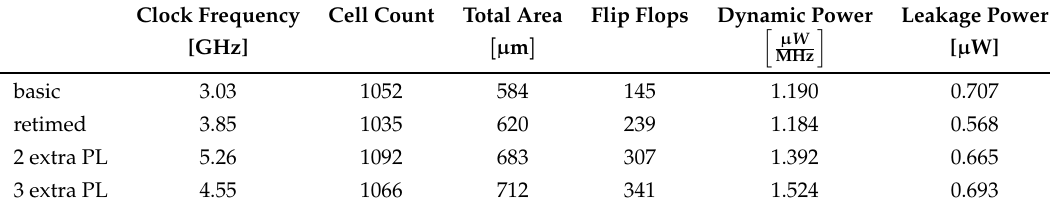
Table 4. ASIC implementation results for the resampler in 14 nm FinFET from Global Foundry technology using 8 bits for d